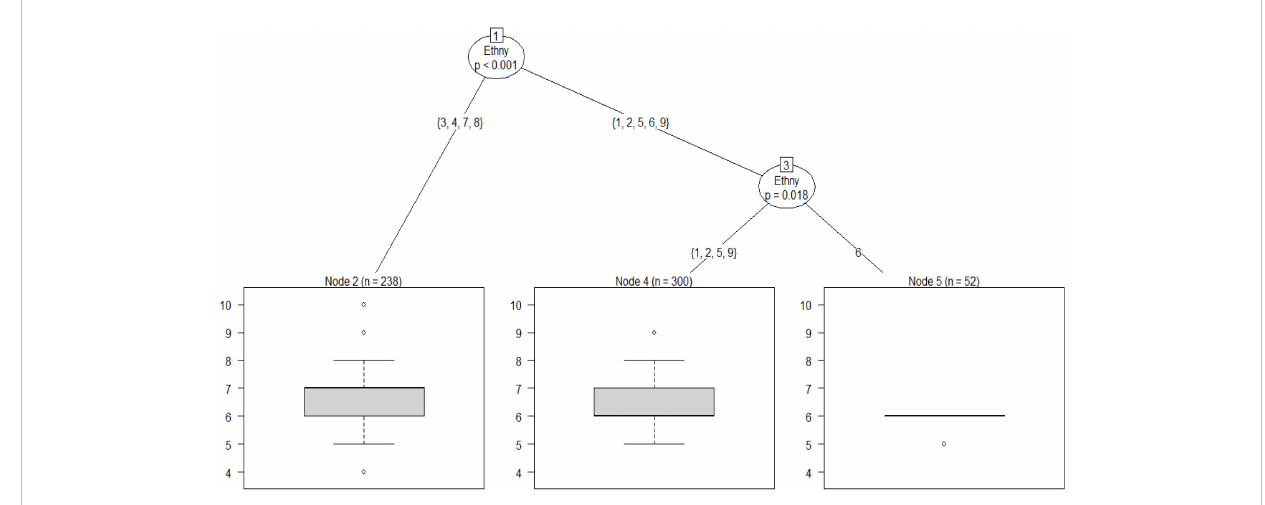
FIGURE 4 Inference trees showing the effects of sociodemographic factors on ethnomedicinal knowledge. 1: Yoruba, Boo, Lokpa, Adja, Pila Pila, Ayizo, Goun, Tori, Wama, Biali, Gando; 2: Isha; 3: Gourmache ́ ; 4: Mahi; 5: Xoli; 6: Bariba; 7: Fon; 8: Nago; and 9: Peuhl.